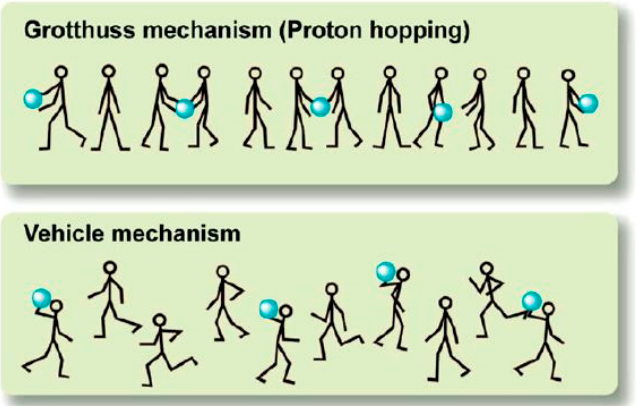
Figure 19. Illustrations of proton conduction mechanisms in acidic aqueous solutions and protic ionic